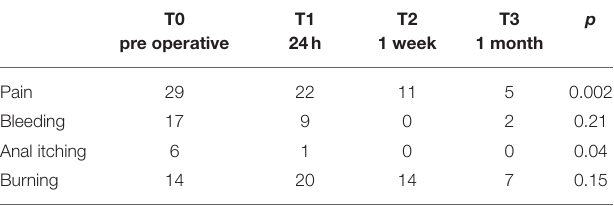
TABLE 3 | Symptoms (number of patients) changes.